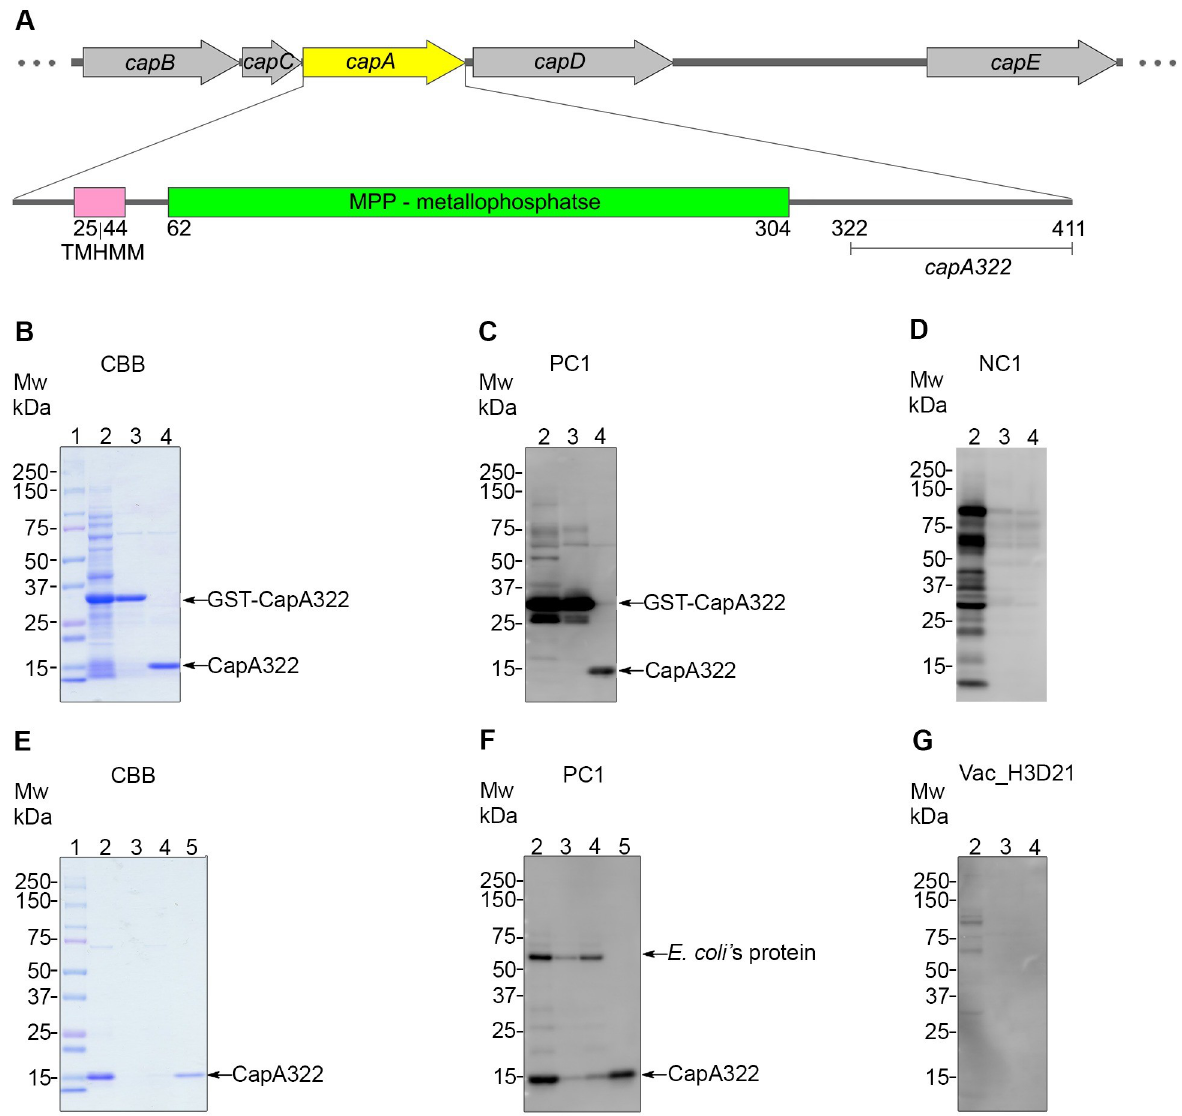
Fig 2. Expression and purification of CapA322. (A) Genetic map of Bacillus anthracis capsule-coding operon revealing the CapA322, C-terminus region (amino-acid 322–411) of CapA used in antigen preparation. (B) Coomassie brilliant blue staining (CBB) and (C, D, and G) Western blotting of the fractions collected after affinity batch purification. In Western blotting, proteins were probed with different horse sera: (C) horse hyperimmunized anti- B . anthracis serum (PC1); (D) naive horse serum (NC1); (G) vaccinated horse serum (Vac_H3D21). Lane 1, Mw, molecular weight marker (in kDa); lane 2, the supernatant fraction applied to affinity beads (GST-CapA322: 37 kDa); lane 3, beads bound; lane 4, elute after treatment with PreScission Protease (CapA322: 11 kDa). (E and F) CBB and Western blotting of the fractions collected during the cation exchange process. Lane 1, Mw, molecular weight marker (in kDa); lane 2, sample loaded onto the cation exchange chromatography column; lanes 3 and 4 flow-throughs; lane 5, the eluted protein. Host cell-derived contaminants indicated as Escherichia coli ’s